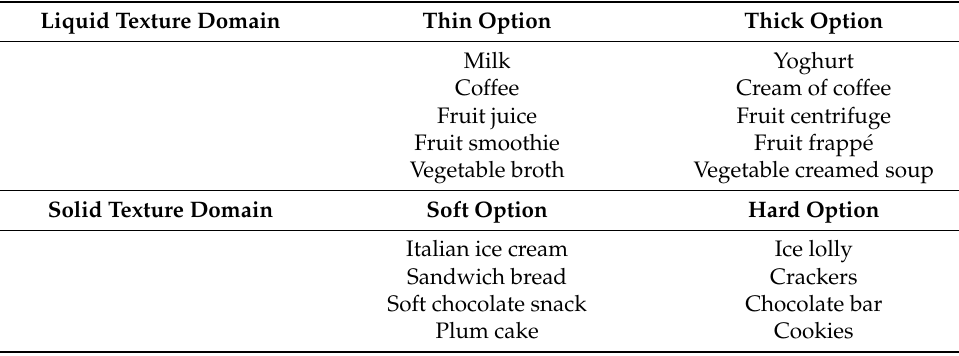
Table 1. Texture dichotomies belonging to two texture domains used in the